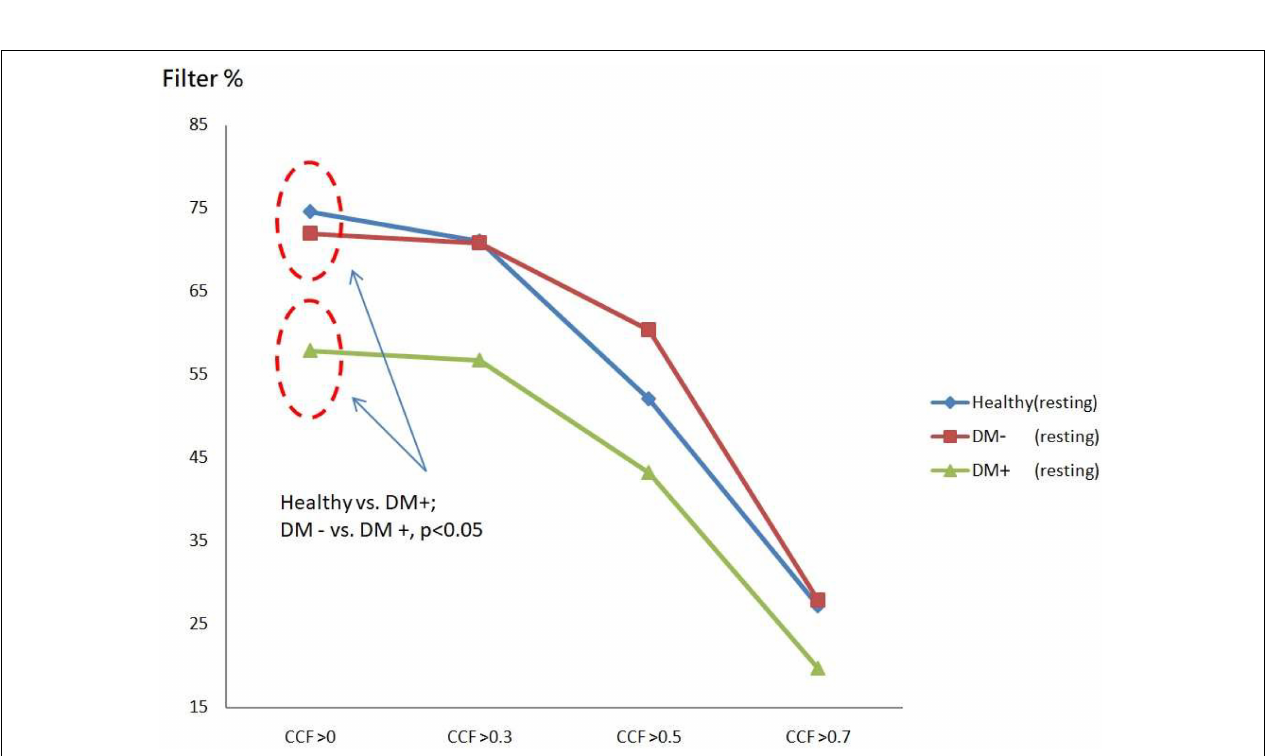
FIGURE 7 | The plot of filter % with different thresholds by ACCF results in the supine position. Filtered maximum CCF value (% to all CCF values) using the threshold CCF > 0, 0.3, 0.5, and 0.7 in resting position in healthy (blue), diabetes mellitus (DM–, red), and DM with autonomic neuropathy (DM+, green). Threshold CCF > 0 allowed to differentiate healthy, DM–, and